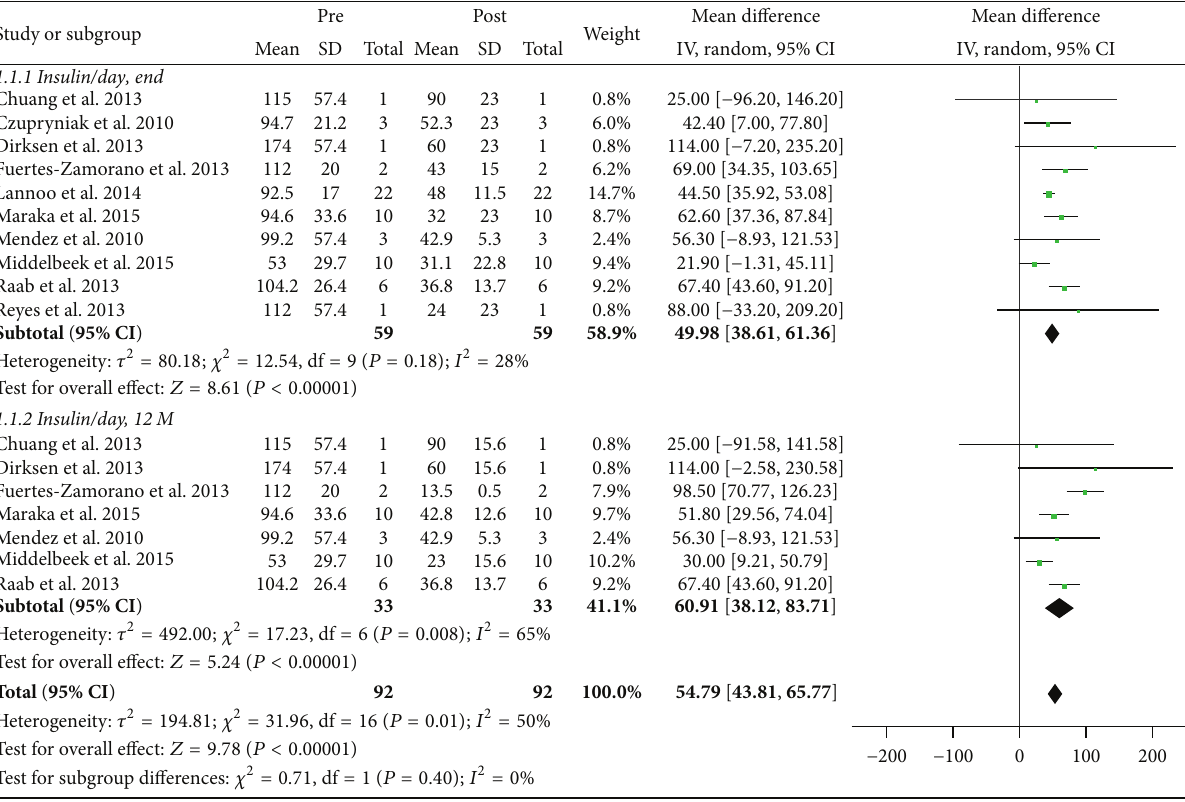
Figure 3: Meta-analysis of changes to total daily insulin requirement postoperatively at 12 months and at study endpoint. End indicates study endpoint; 12M, at 12 months; pre, preoperative; post, postoperative; CI, confidence